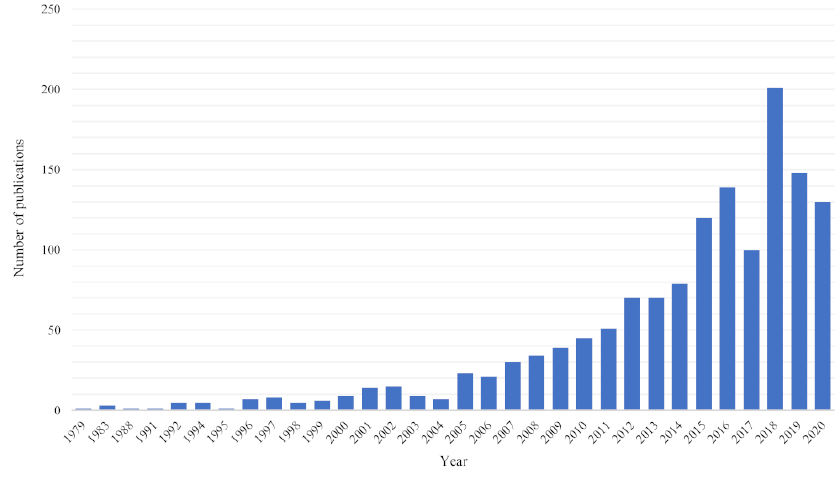
Figure 1. Number of publications per